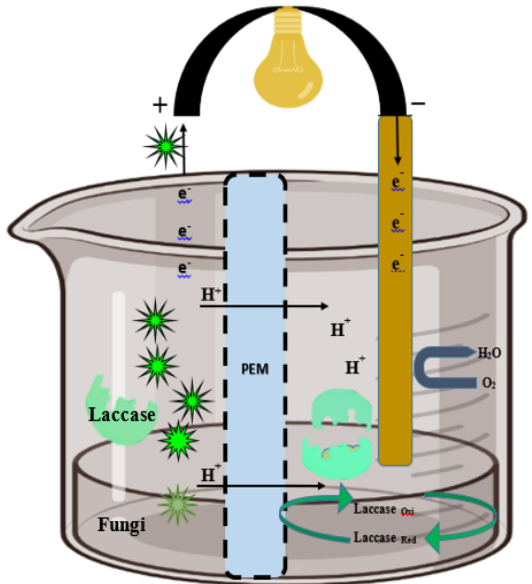
Figure 4. Extracellular fungal laccase catalyst in the anodic chamber, which enzymatically oxidizes wastes during wastewater treatment in the cathodic chamber with reduction of O 2 into water. The movement of e - from the anode to cathode lit the bulb during the completion of